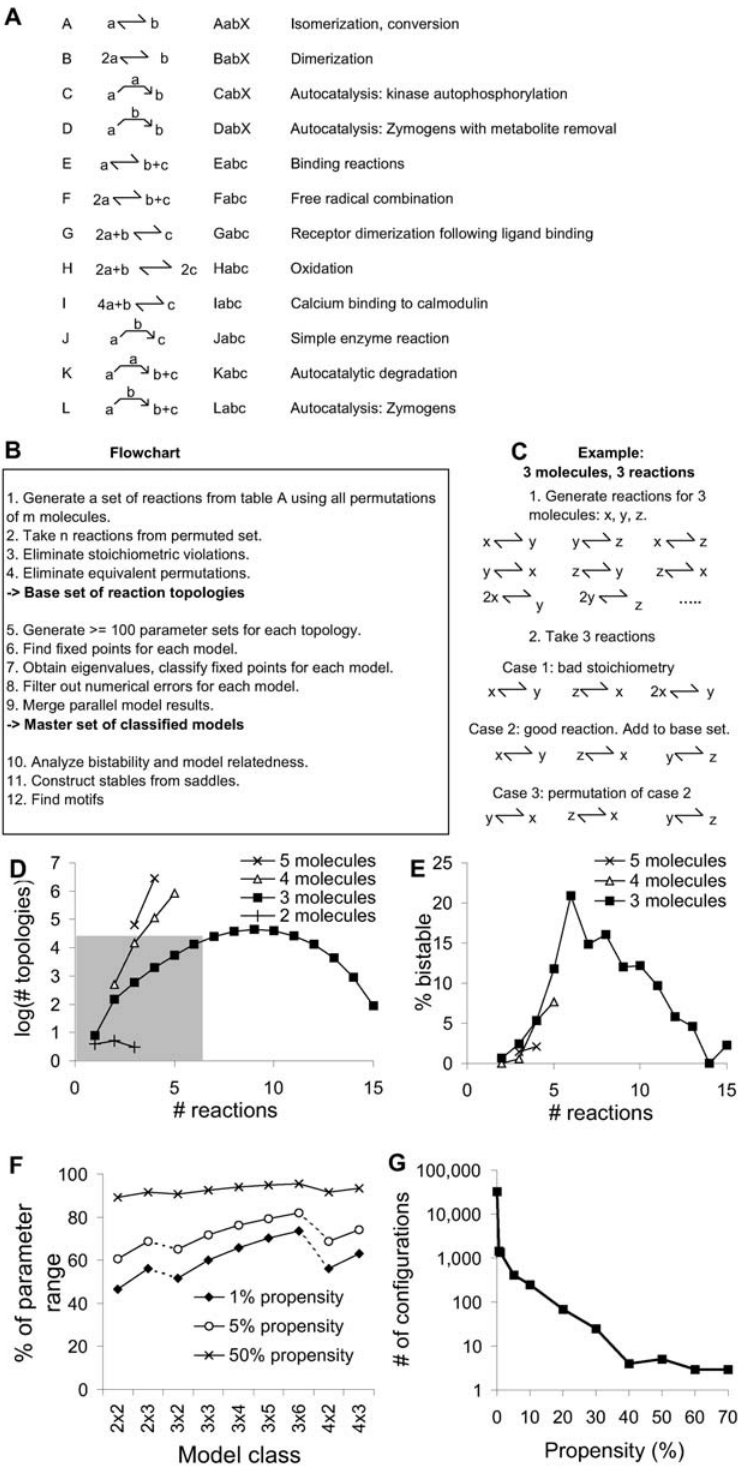
Figure 1. Finding Bistability. (A) Basis set of reactions with signatures and examples. Reactions C, D, J, K, and L are enzymatic and the enzyme name is at the bend of the arrow. (B) Flowchart for finding bistability. (C) Example of steps 1–4 in the flowchart. (D) Number of possible configurations rises steeply with increasing number of molecules and initially also with the number of reactions. Shaded region indicates configurations fully sampled in this study, the remainder were subsampled. (E) Bistable configurations initially become more common with increasing numbers of reactions, and for 3 molecules the percentage declines for more than 6 reactions. (F) Bistability must persist over a wide parameter range to be detected. Fraction of parameter range= # parameters ! (Propensity). Model class is expressed as m 6 n where m is the number of molecules and n is the number of reactions. (G) Frequency of occurrence of bistability as a function of propensity. Some configurations exhibit bistability over 30% of any parameter set in our selected range.